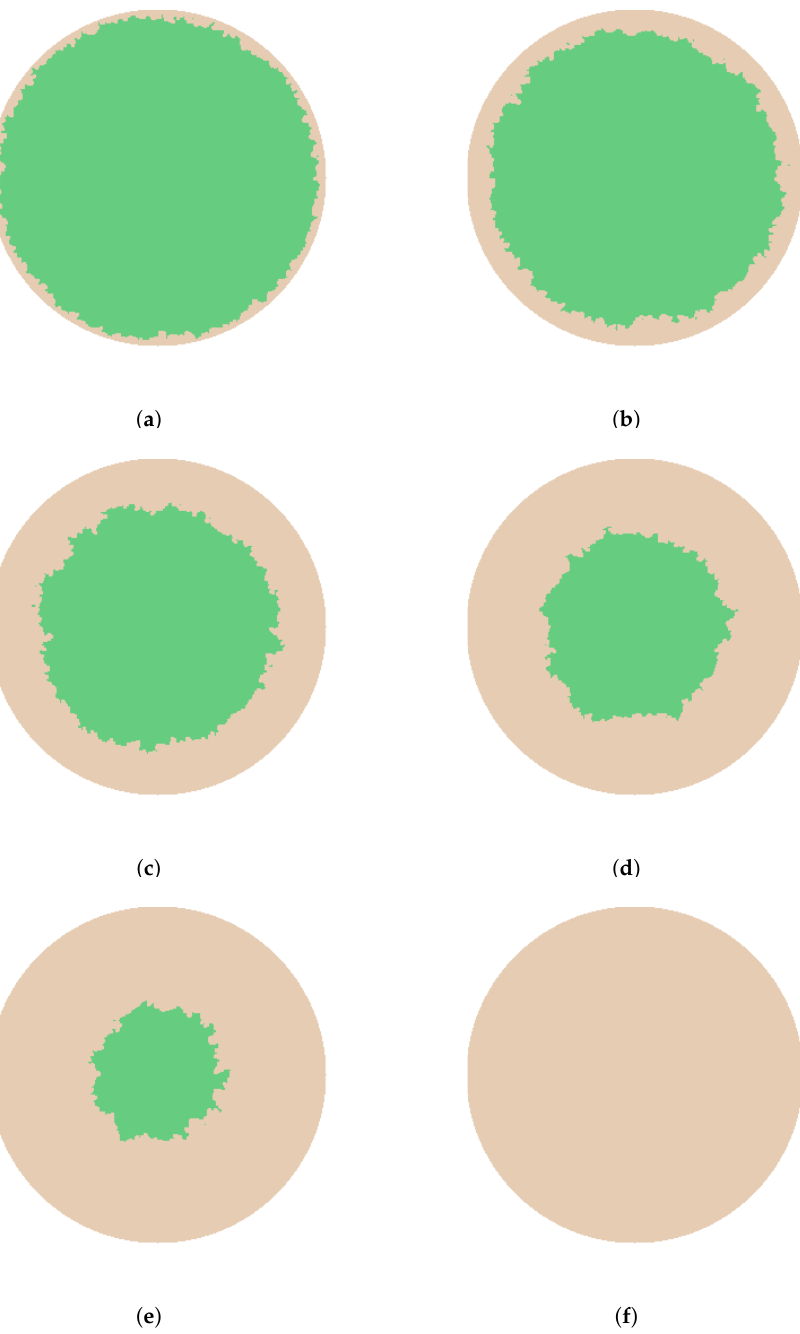
Figure 2. Eden model simulation of epithelialization for a circular skin wound. is wound space and is epithelialization. Different stages of the onset and progression of epithelialization showing wound contraction and leading closure are given in ( a – f ), representing 10%, 25%, 50%, 70%, 85%, and 100% re-epithelialization,